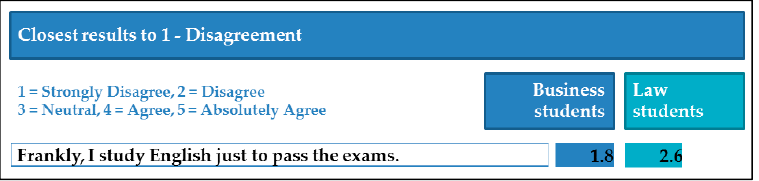
Figure 4. Business students’ and Law students’ motivations to study ESP.